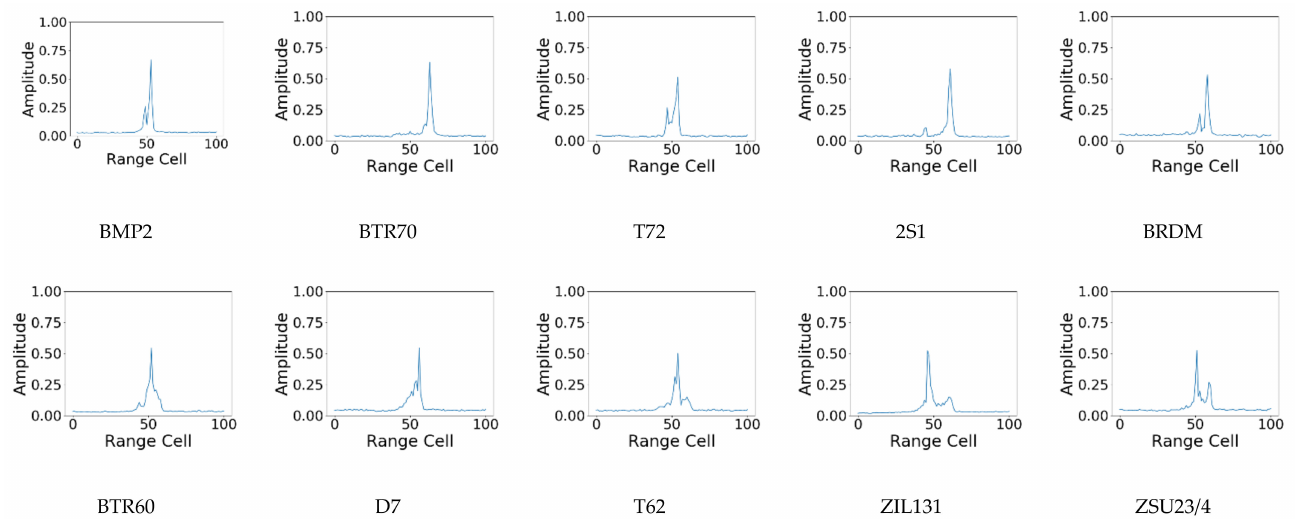
Figure 6. The average profile examples of the generated HRRP data of the ten different targets in the MSTAR dataset. For the MSTAR data, we use the complex-valued SAR images provided by the